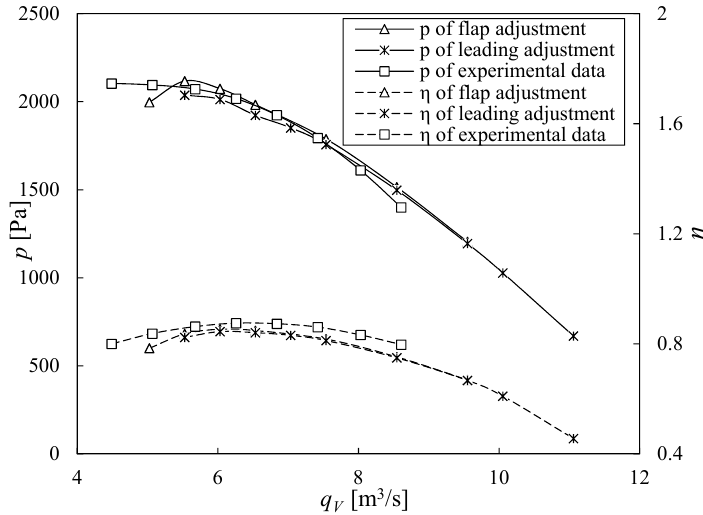
Figure 5. The performance curve comparison of FE results and the experimental data.